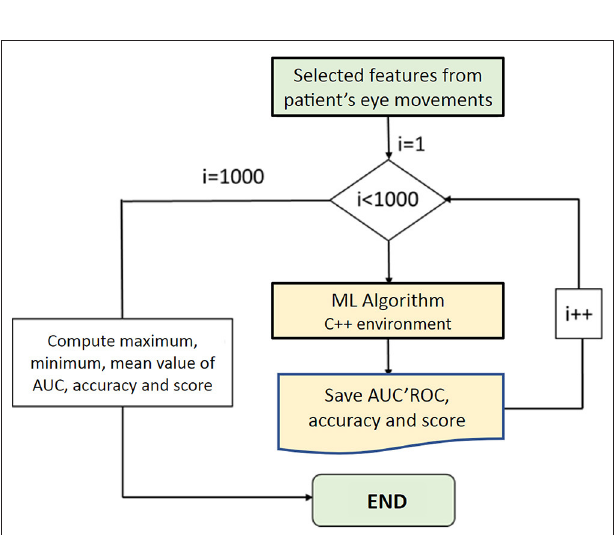
FIGURE 2 | Loop implemented to test the confidence interval of the selected machine learning algorithm. AUC, area under the curve; I, iterations; ML, machine learning; ROC, receiver operating